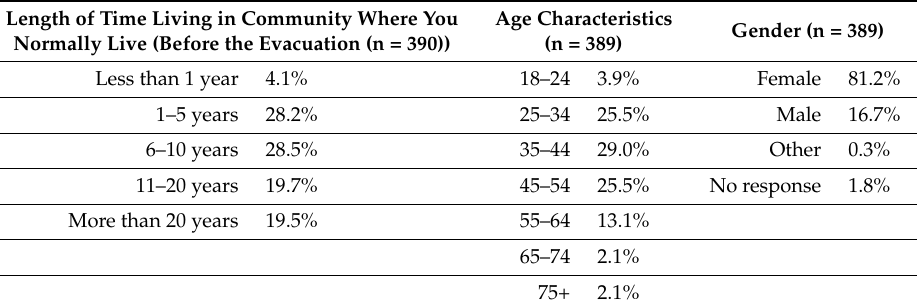
Table 1. Demographic characteristics of online survey